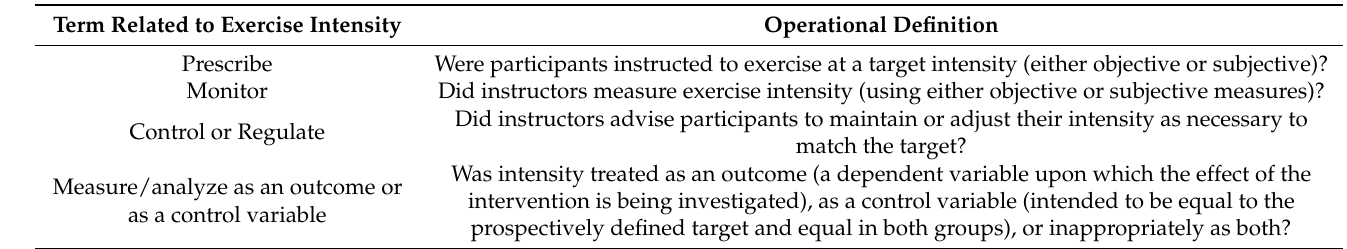
Table 3. Operational definitions of terms related to regulating and measuring exercise